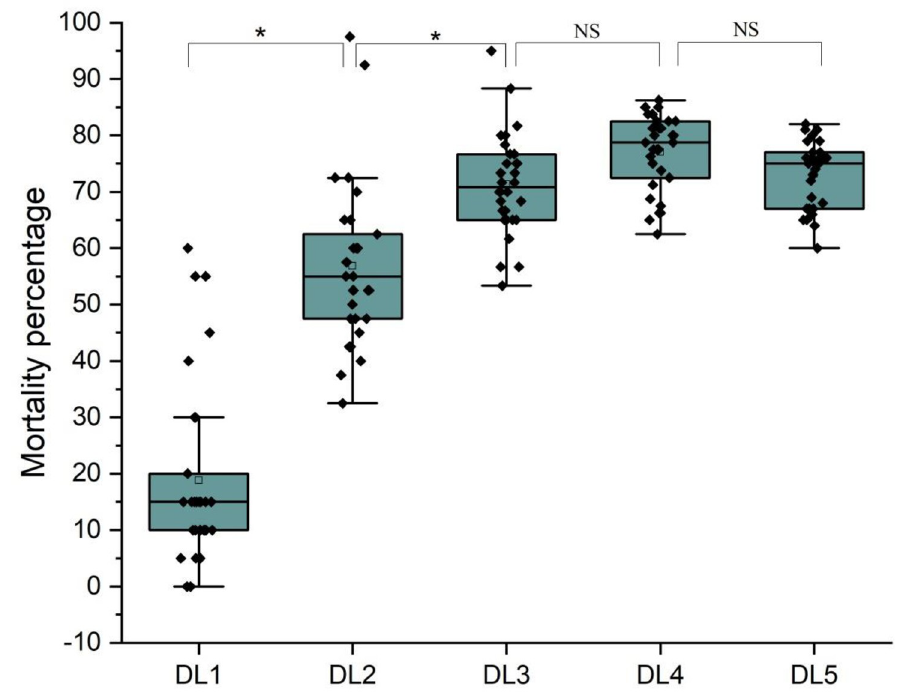
Fig 1. Mortality (M%) in Acridids at different density levels (DL1 to DL5). The upper and lower quartiles of each box represent the range of species mortality. M% for 31 species are represented by 31 dots in a box, where the line in the interquartile range represents the median value. Kruskal–Wallis test among DLs ( F 4, 154 = 146.133, p = 0.000, at 5%) reveals a significant difference in mortality across DLs. Dunn’s test analysis (0.05) reveals that M% differs significantly between DL1 and DL2 ( p = 0.0) and DL2 and DL3 ( P = 0.0), but not between DL3 and DL4 ( p = 0.2894) and DL4 and DL5 ( p =